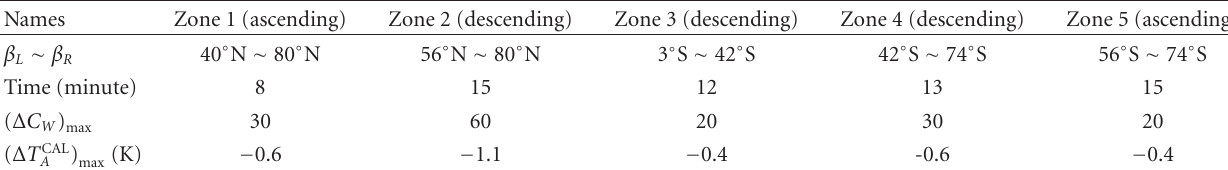
Table 2: Warm load count anomaly zone identified from SSMIS data March 20, 2005. β L ∼ β R denotes the latitudes of each anomaly zone is the maximum warm load count anomaly for each zone and is estimatedaccording width in the left and right sides, respectively. ( Δ C W ) max ) is the error in SSMIS radiance corresponding to ( Δ C W ) to Figure 3(a). ( Δ T CAL A max − ( T − T − C A C ) / ( C W C ) Δ C W ).